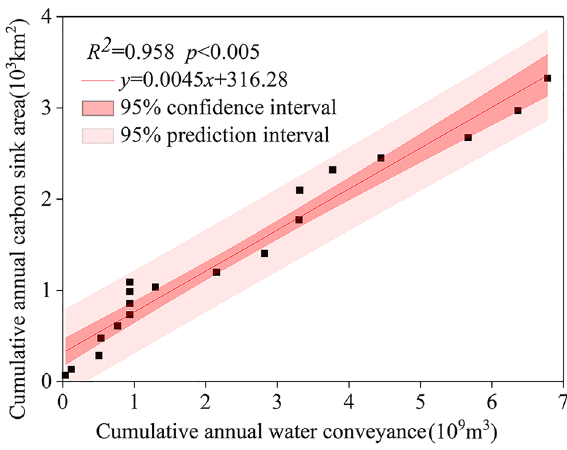
Figure 5. Linear fitting chart of cumulative water conveyance and cumulative carbon sink in the lower reaches of Tarim River.